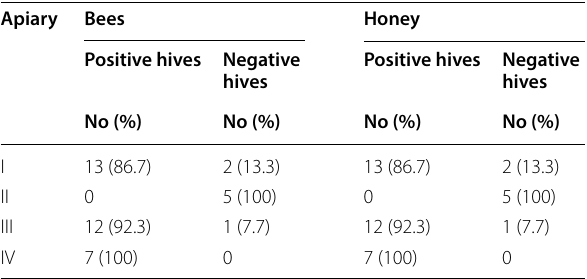
Table 1 Results of molecular tests on bees and honey to demonstrate suitability of honey as sample for viral diseases detection Apiary Bees Honey Positive hives Negative